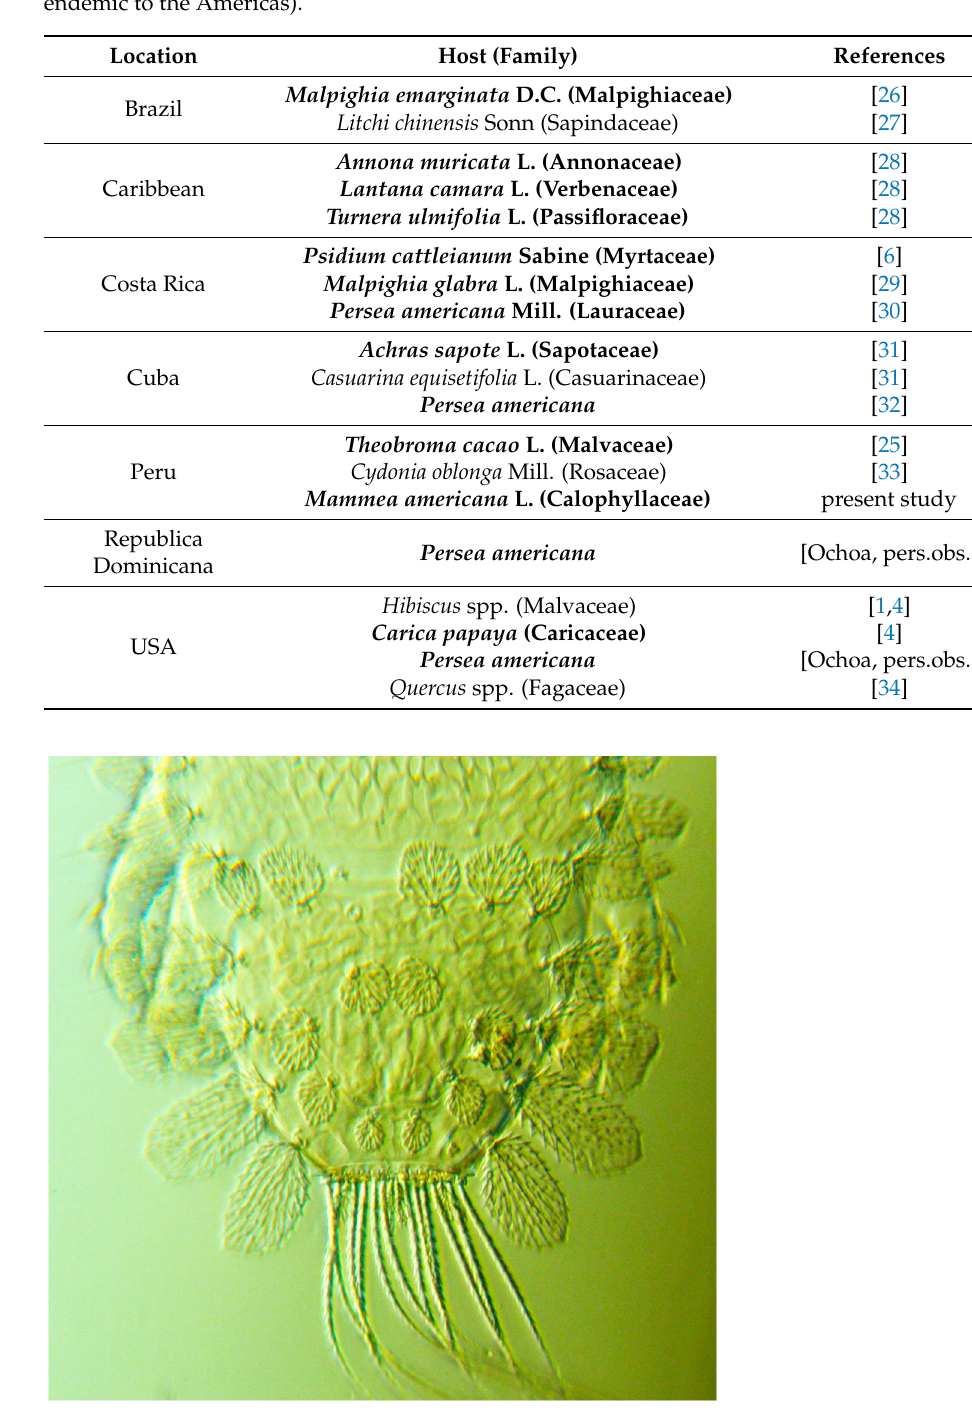
Figure 5. Aggregations of adult Tuckerella pavoniformis on Mammea americana with one or more eggs and/or immatures (indicated by black arrows) on branchlets sections ( A , B ) and fruit epicarp ( C , D ). The analysis of the biometric characteristics recorded for ripe fruits of M. americana infested by T. pavoniformis revealed an average weight of 397.23 ± 20.79 g, with individual